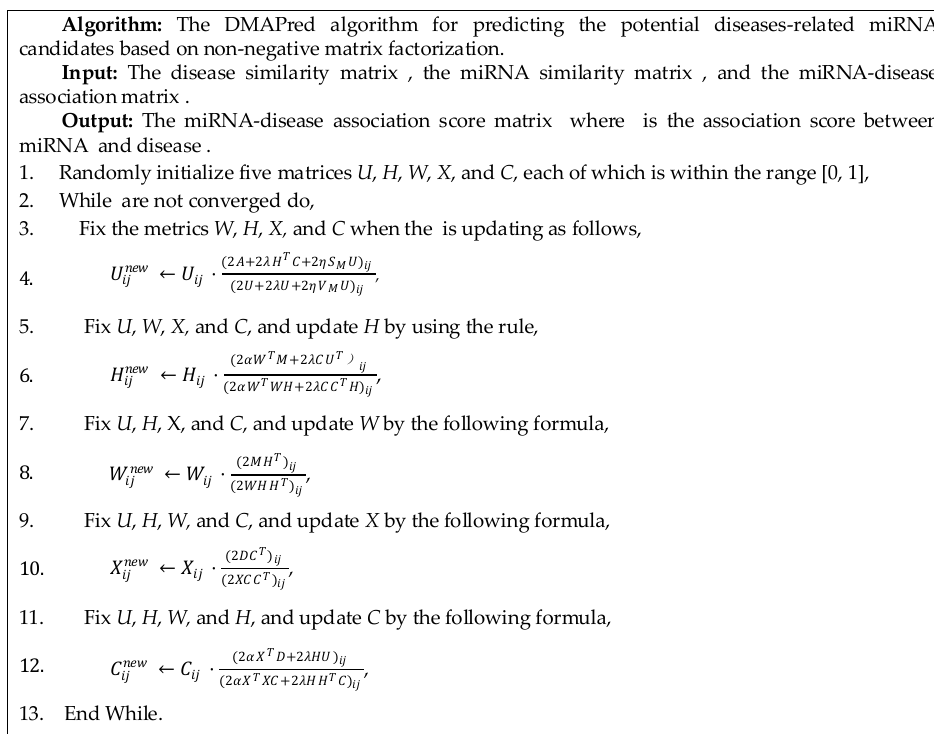
Algorithm: The DMAPred algorithm for predicting the potential diseases-related miRNA candidates based on non-negative matrix factorization.